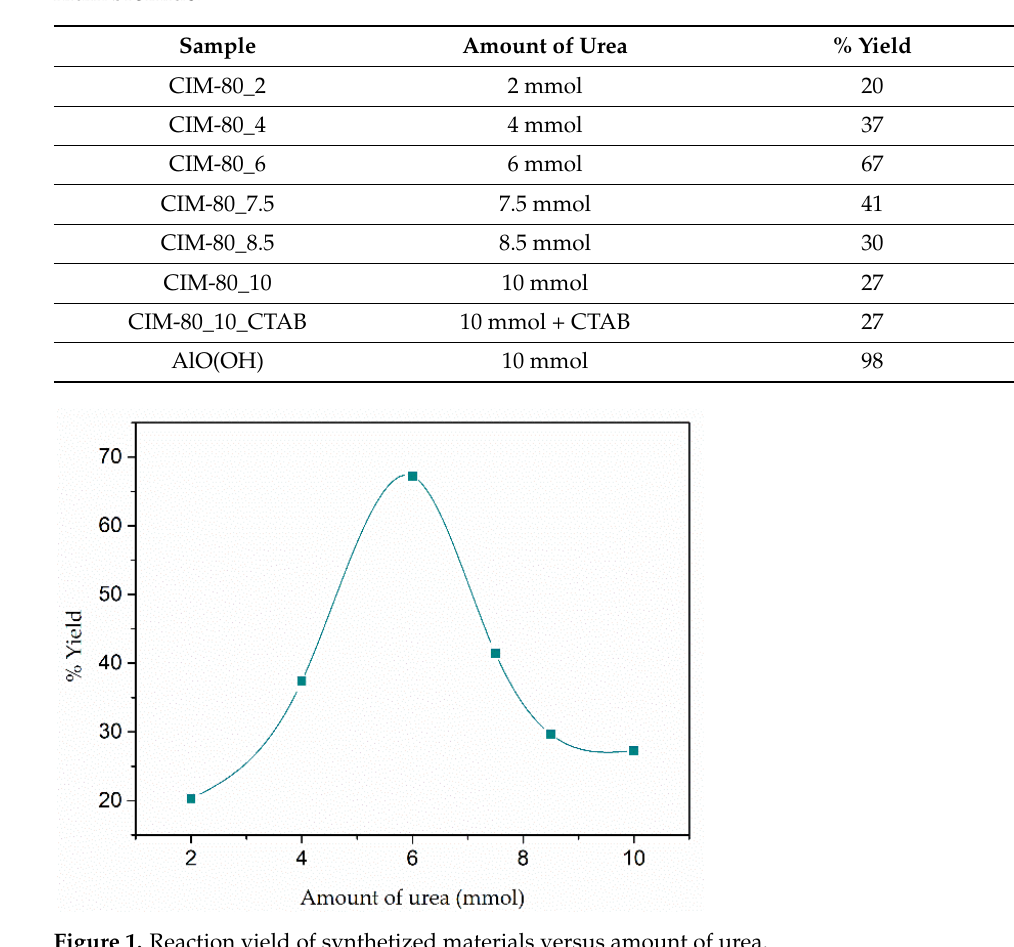
Table 1. Reaction yield obtained in each synthesized material. The nomenclature of the samples is composed by the MOF name_amount of urea used in the synthesis. CTAB = to cetyltrimethylammo- nium bromide.